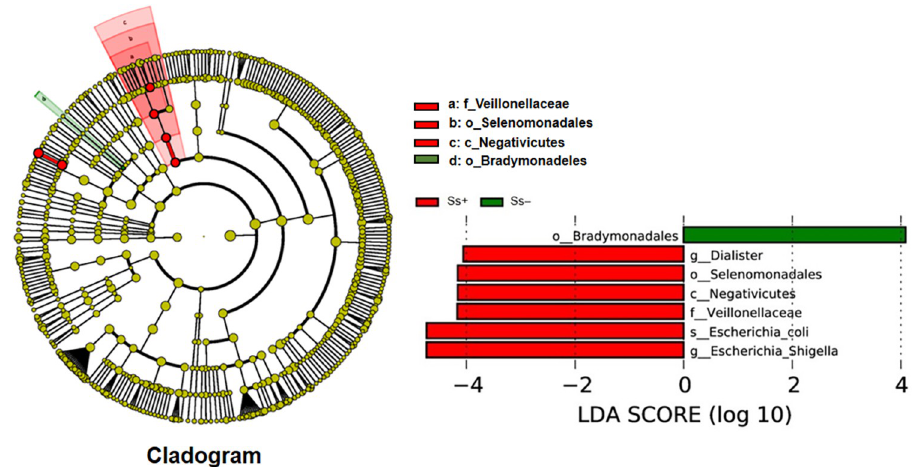
Fig 3. Histogram of cladogram and linear discriminant analysis (LDA) score. The histogram of the LDA scores presents taxa (potential biomarkers) whose abundance differed significantly among groups (Ss+ vs. Ss-) order Bradymonadales in Ss- (green color). Species E . coli belongs to the genus Escherichia-Shigella ; genus Dialister belongs to the order Selenomonadales, class Negativicutes and family Veillonellaceae in Ss+ (red color). The cladogram shows specific taxa relevant to Ss+ and Ss- in the red and green nodes. The highest taxonomic level is towards the center of the diagram. The diameter of each circle represents the relative abundance of the taxon.